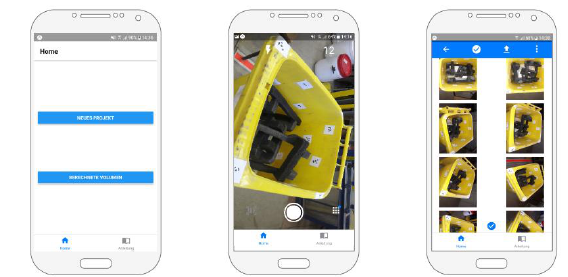
Figure 1: Different screens of the final app (project definition, image acquisition, and image